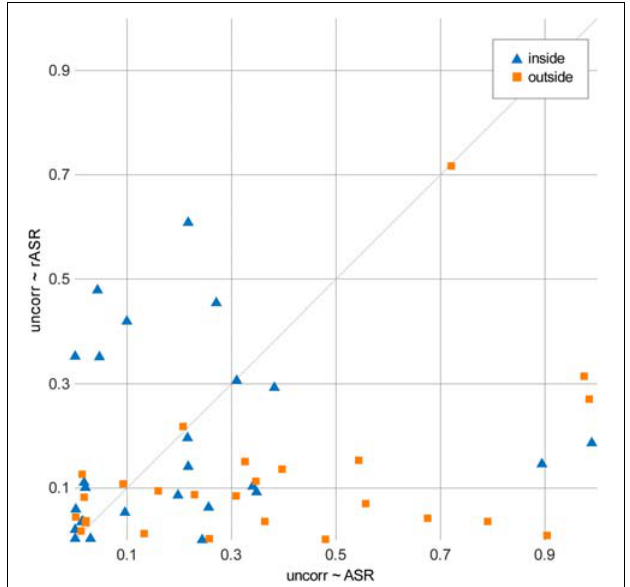
FIGURE 5 | Artifact correction computation times per method and extend of used functions for the two artifact-correction procedures, measured on a laptop running Matlab 2016a, Intel R (cid:13) i7 (quadcore) processor and 16GB RAM. The median is shown by the line which divides the boxes, outliers are indicated by crosses outside the whiskers. The core functions contained the Riemannian adaptation and therefore show the biggest difference in computation time. When computation time for all preprocessing functions was measured, the difference was less pronounced since these functions include unchanged